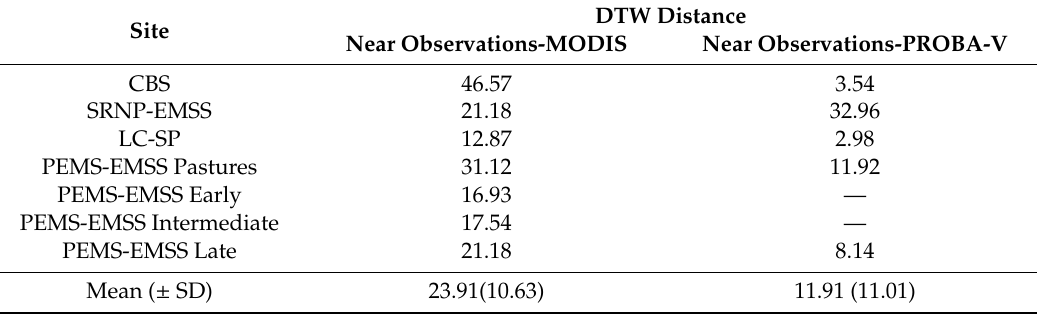
Table 2. Minimum global distance computed using the dynamic time warp algorithm to compare the di ff erences of standardized NDVI time series between satellite and near-surface observations at four tropical dry forests. Observations at the Parque Estadual da Mata Seca (PEMS-EMSS) come from four successional